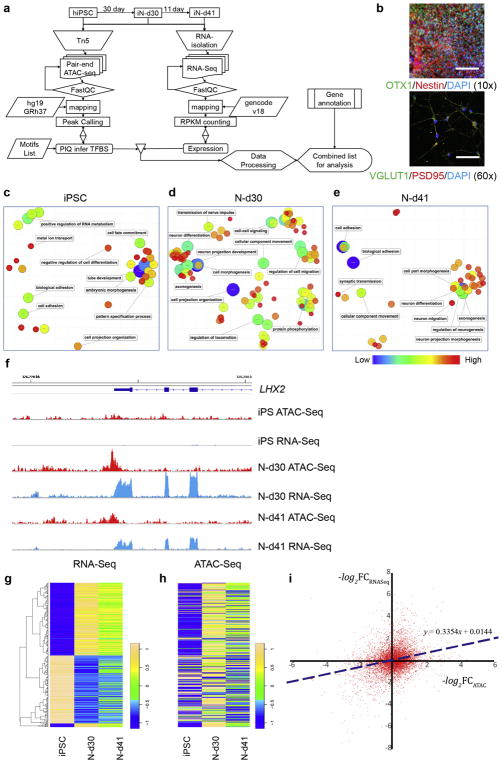
Open chromatin dynamics and correlation with gene expression during cortical neuron differentiation. (A) Flowchart showing the cell preparation, ATAC-seq open chromatin mapping, and RNA-seq analysis. (B) Immunofluorescence (IF) staining of cortical NSCs (OTX1+/Nestin+; top panel) and N-d41 glutamatergic neurons (VGLUT1+/PSD95+; bottom panel). Scale bar = 120 μm and 20 μm, respectively. (C–E) GO-term enrichment analysis of cell stage-specific OCR peaks during cortical neuronal differentiation from hiPSCs, showing the GO-term (biological process) enrichment for open chromatin peaks at different specific stages (C) hiPSC, (D) N-d30, (E) N-d41. The GO-term enrichment was generated by DAVID (v6.7). The enriched GO-terms at FDR < 0.05 were clustered and visualized by REVIGO. Scale bar indicates the statistical significance of the enrichment (blue = lowest P values, i.e. highest significance of enrichment). (F) ATAC-seq peaks (upper, red) and RNA-seq peaks (lower, blue) near the 5′-end of LHX2, a forebrain-specific gene in hiPSCs, N-d30, and N-d41 neurons, showing the strong correlation between ATAC-seq and RNA-seq peak intensities. (G–H) Heat maps showing the expression ratio (normalized RPKM) of the 272 genes (G) and their normalized ATAC-seq read counts ratio at its promoter-TSS peaks (H). The 272 genes are most variable ones with >4-fold of expression changes between hiPSC and N-d30 stages (FDR < 0.005); (I) XY scatter plot showing the correlation between ATAC-seq read-count fold-change within Promoter-TSS and the expression fold-change (RNA-seq). The negative logarithmic values the r ATAC-seq read-count fold-change within Promoter-TSS and the expression fold-change (RNA-seq) between hiPSC and N-d41 stages were plotted.